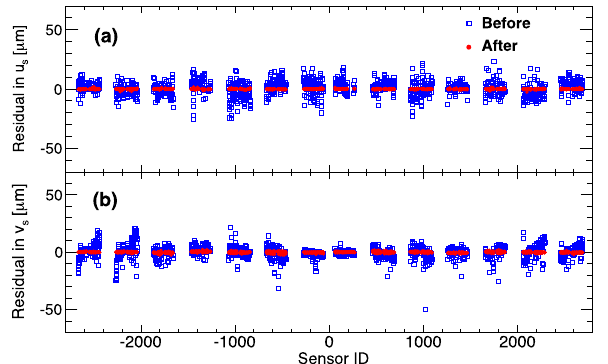
Fig. 27 The rigidity-scale shifts as a function of time over 10 years obtained from the event rates of cosmic-ray protons (open symbols) and helium (full symbols) measured using the inner tracker ( R 28 , circles), L1 and the inner tracker ( R 18 , squares), and the full-span tracker ( R 19 , triangles). The solid curve shows the fit with a logistic